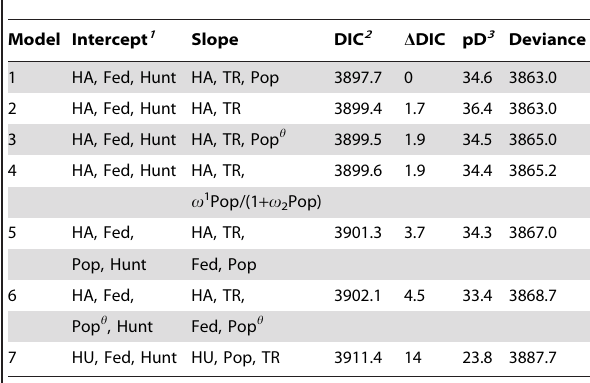
Table 1. Comparison of hierarchical Bayesian logistic regressions of 6458 brucellosis test results of adult female Wyoming